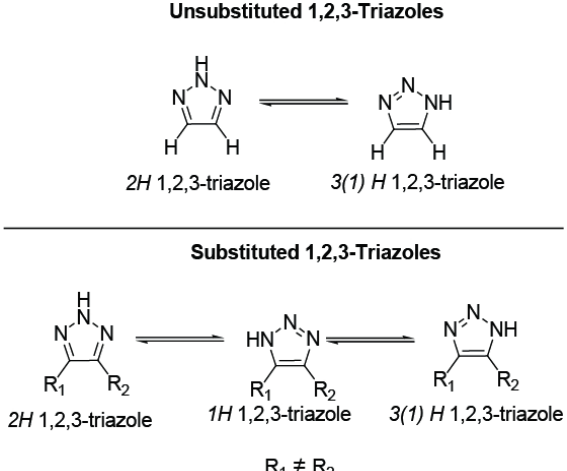
Figure 3 - Different tautomers of substituted and unsubistitued